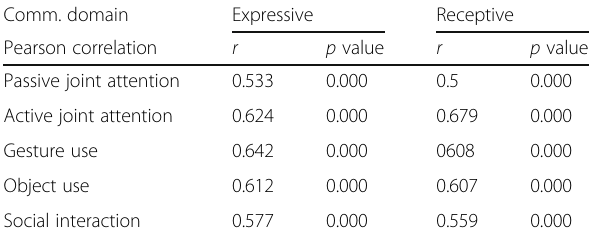
Table 9 The correlation between the scoring in expressive language scale and expressive language scale in one hand and scoring in each of the seven scales Comm. domain